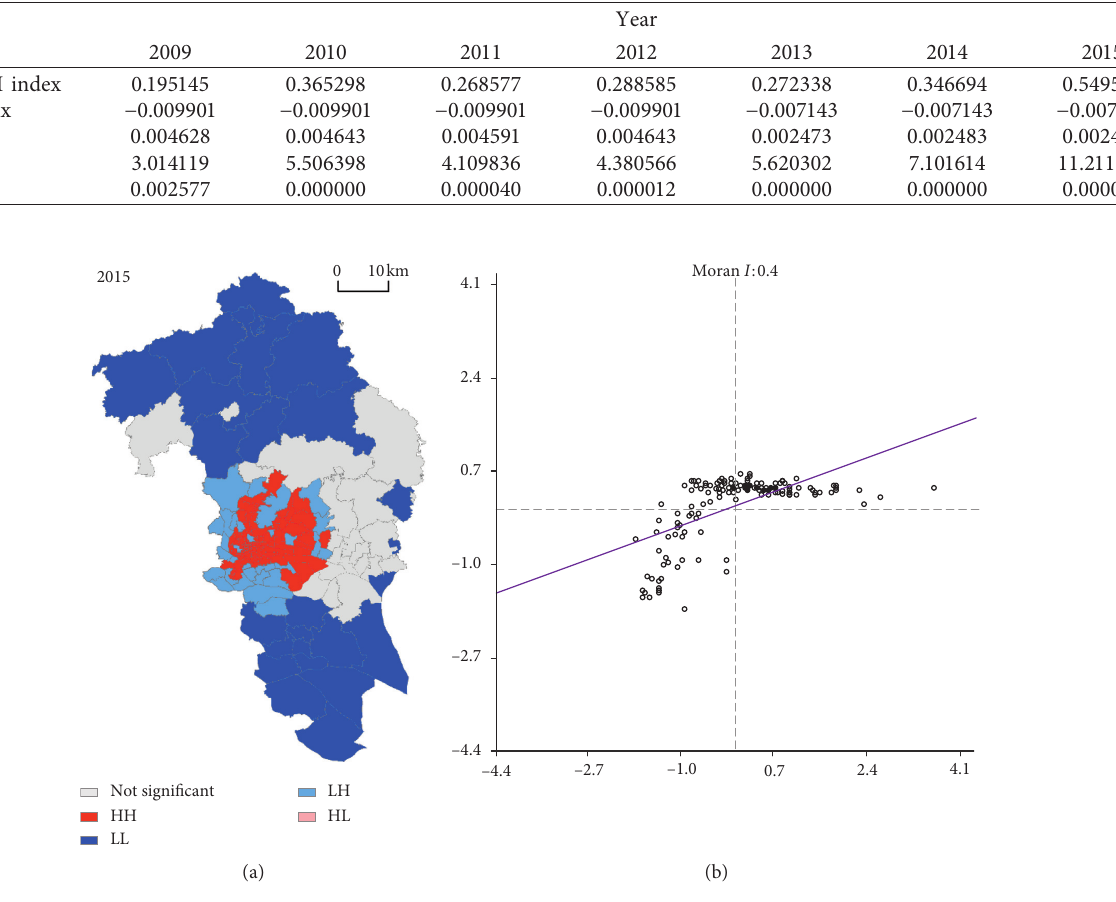
Table 3: Results of the global Moran’s I index analysis.